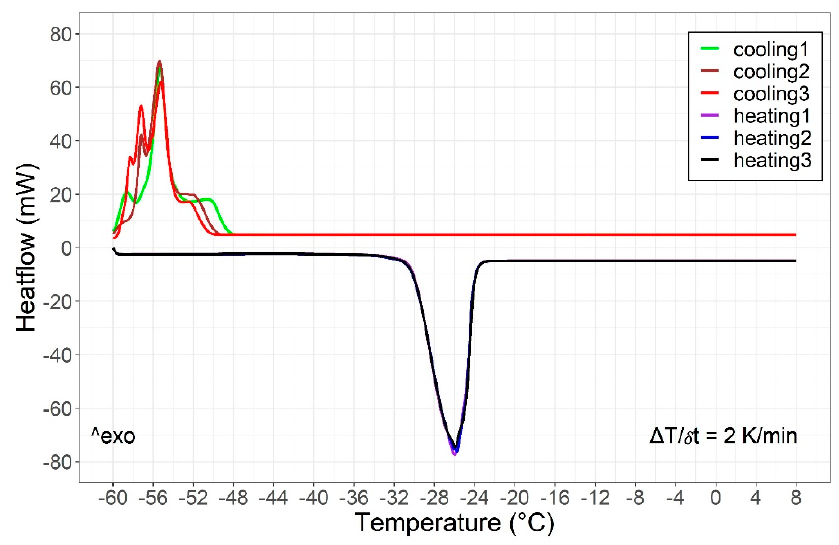
Figure 5. Three repetitions of heating and cooling curves of Al(NO 3 ) 3 /water 30.5 wt.% as they were measured by DSC at 2 K/min.